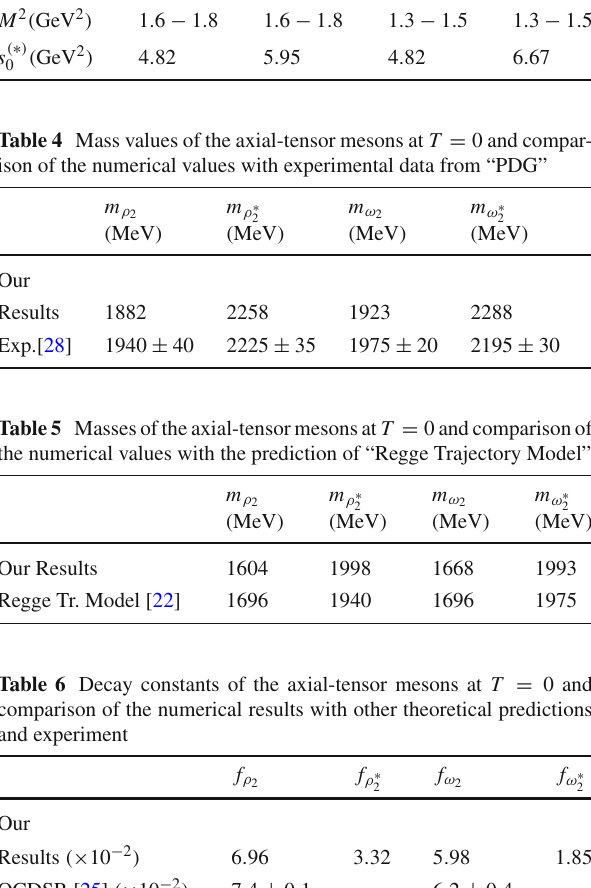
Table 3 Borel and continuum threshold parameters working regions ( ∗ ) ( ∗ ) for the ρ and ω considering “Regge Trajectory Model” 2 2 Parameter